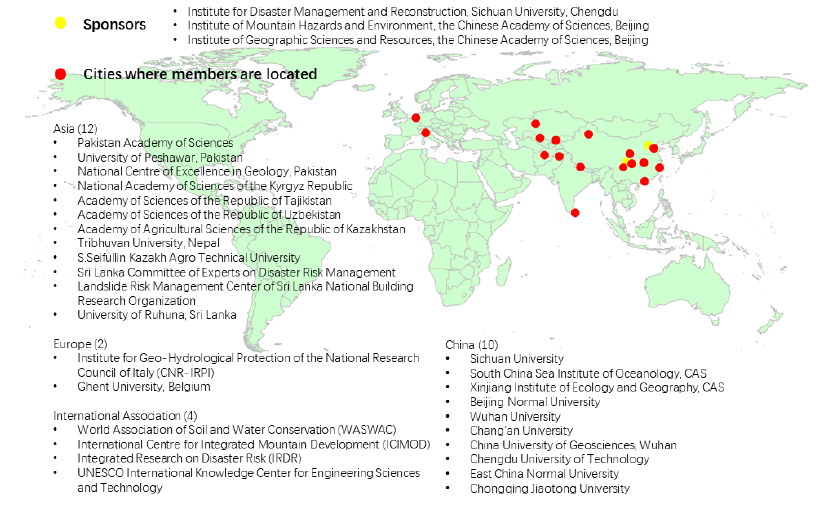
Figure 1. Sponsors and members of the Alliance of International Science Organizations on Disaster Risk Reduction (ANSO-DRR).